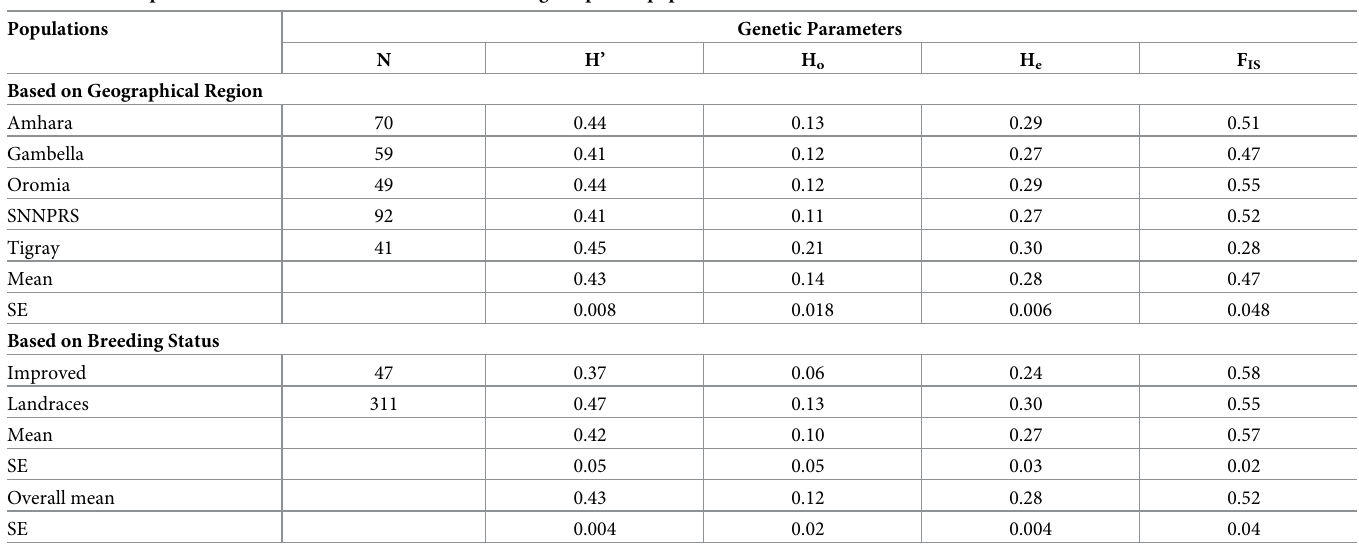
Table 1. Genetic parameter estimates based on 6498 SNPs among cowpea subpopulations.